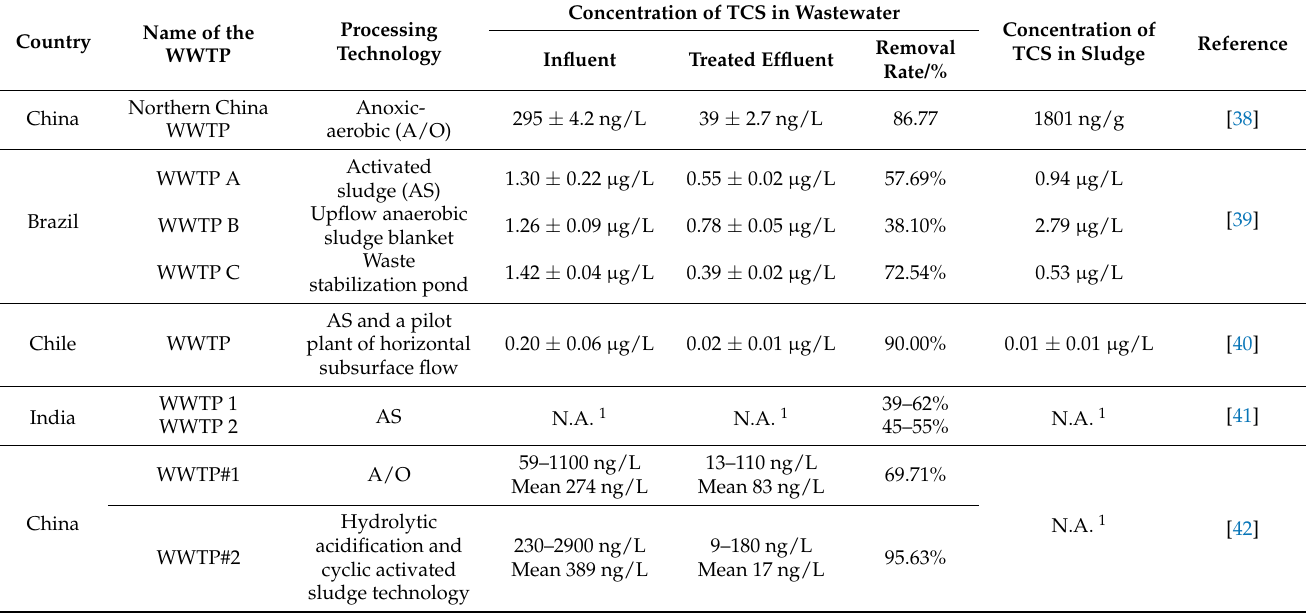
Table 1. The concentrations of TCS in WWTPs.